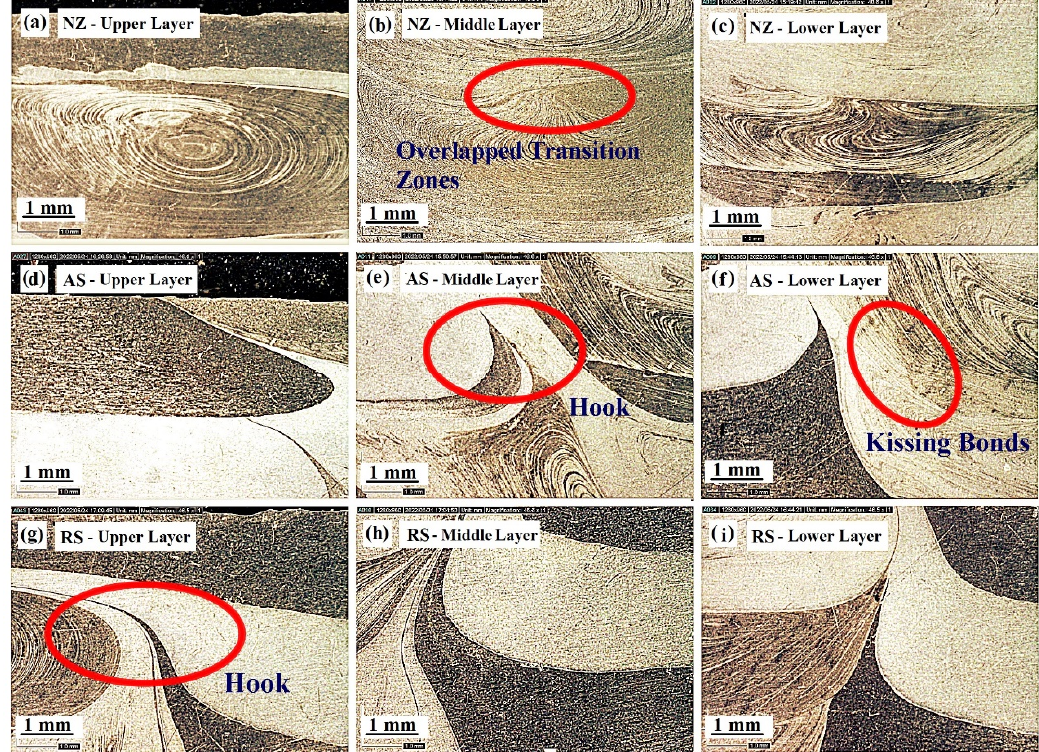
Figure 5. Formation morphology found in cross-section ( a – c ) NZ in upper, middle, and lower layer, ( d–f ) AS in upper, middle, and lower layer, and ( g – i ) RS in upper, middle, and lower layer.